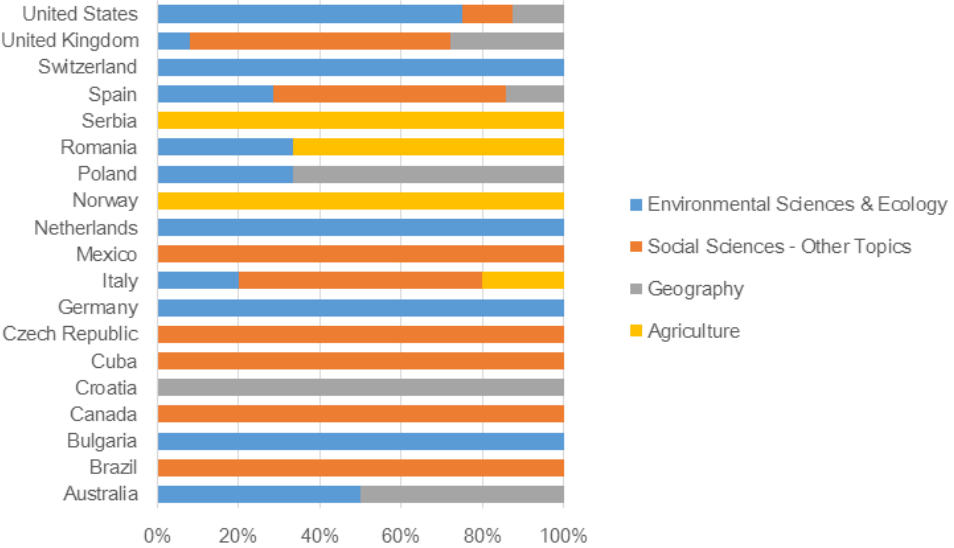
Figure 10. Distribution of journals by area and country of publication in WoS. Source: Authors’ own data.